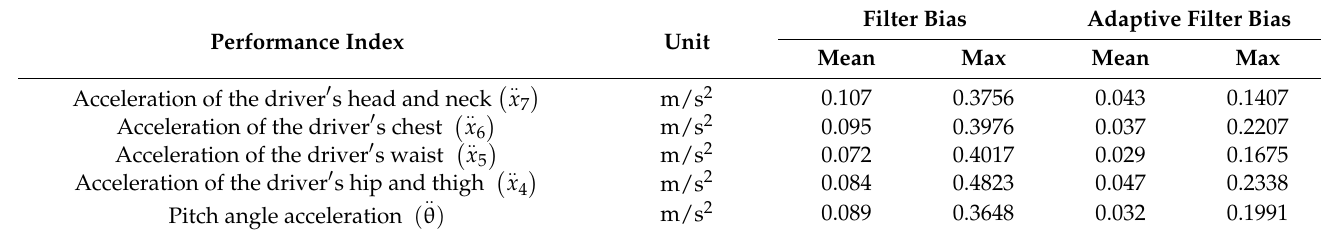
Table 7. Kalman filter bias values of immeasurable performance